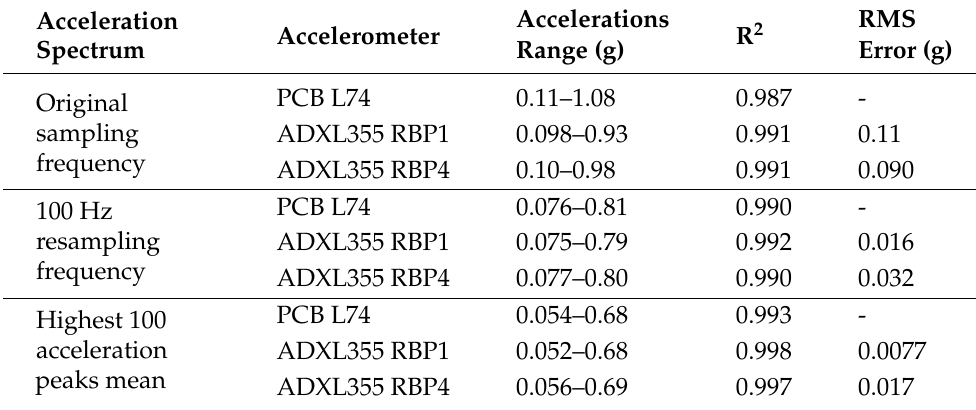
Figure 13. Acceleration spectra for the 0.50 cm displacement frequency chirp: ( a ) Maximum accelera- tion spectrum from original sampling frequency. ( b ) Maximum acceleration spectrum from 100 Hz resampling frequency. ( c ) Acceleration spectrum from the mean of the highest 100 acceleration peaks from 100 Hz resampling frequency. Table 5. Summary of the results obtained from the 0.50 cm displacement frequency